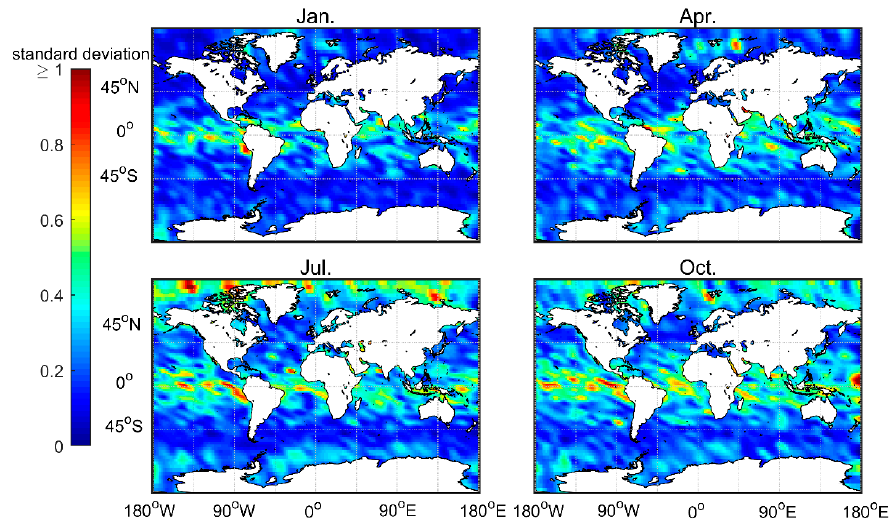
Figure 10. The distribution of the standard deviation for the average MBLH over four months, based on COSMIC’s 2007–2011 atmprf bending angle data.